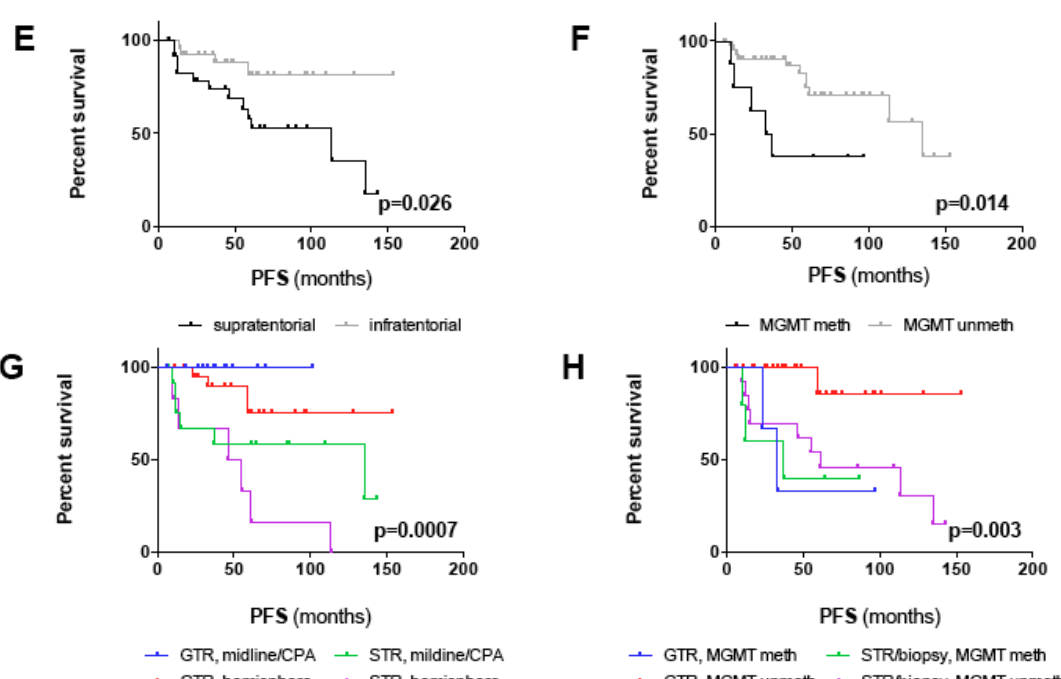
Figure 2. Survival analysis of the outcome cohort including all patients with a follow-up > 24 months and all patients with progression/recurrence irrespective of follow-up (n = 54): ( A ) Diagram depicting time points of tumor progression/recurrence for each individual patient (n = 16). The dotted line marks progression/recurrence within 24 months, the dashed line within 60 months. In 14/16 patients, progression/recurrence occurred within 60 months after 1 st diagnosis. ( B – H ) Kaplan–Meier plots depicting PFS (in months) for ( B ) the outcome cohort and for ( C – F ) all clinico-pathological factors with significant prognostic impact in univariate survival analysis (log-rank test; threshold of significance: 0.05): ( C ) GTR vs. STR vs. biopsy ( p = 0.0006), ( D ) adjuvant RT vs. no RT ( p = 0.04), ( E ) supratentorial vs. infratentorial tumor location ( p = 0.026), ( F ) methylated vs. unmethylated MGMT promoter ( p = 0.014). ( G , H ) Kaplan–Meier plots depicting PFS for patients with midline/CPA and hemispheric tumors ( p = 0.0007) ( G ) and methylated and unmethylated MGMT promoter ( p = 0.003) ( H ) stratified for the EOR (GTR vs. STR/biopsy). Note that statistical significances in ( G ) and ( H ) account for comparison of all four groups. P-values for comparison of distinct groups are given in the main text.